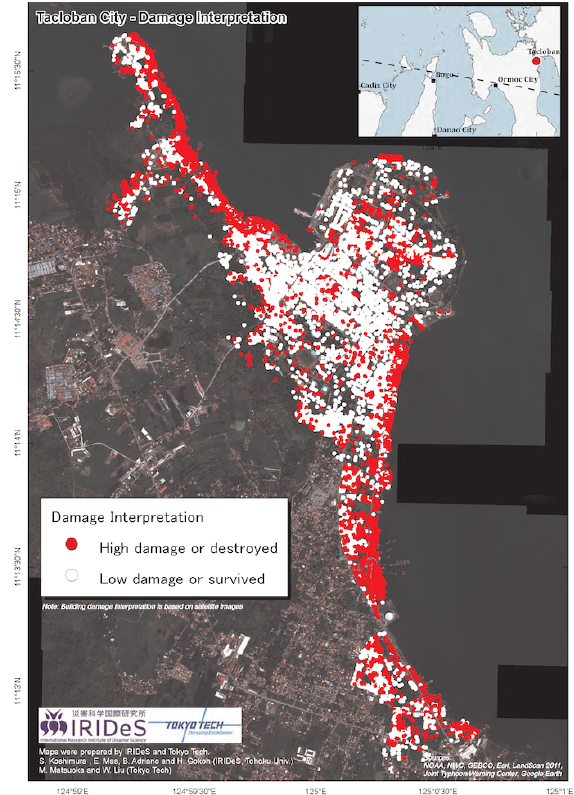
Figure 3. The results of the visual damage assessment using pre- and post-event satellite images and two classification criteria. (i) High damage or destroyed in red and (ii) low damage or survived in